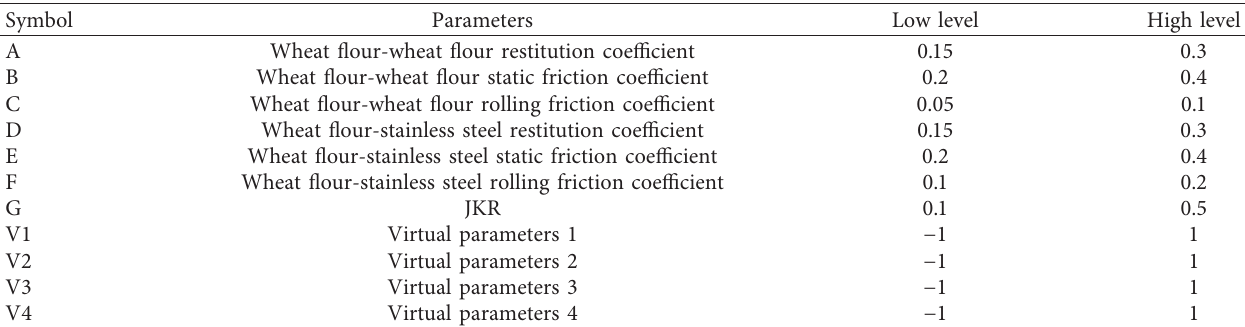
Figure 5: Simulation of wheat flour screw conveying. (a) Simulation process. (b). Post-processed mass flow rate. Table 2: Parameters of Plackett-Burman experiment.